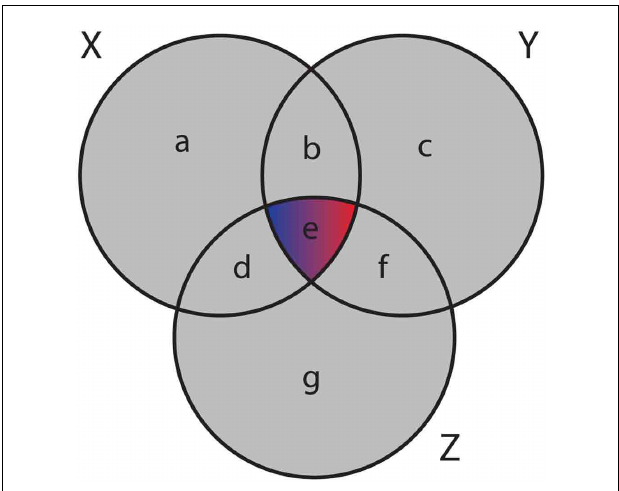
FIGURE 4 | GeneralizedVenn diagram showing the synergy Syn( X , Y ; Z ) =− I ( X ; Y ; Z ). The synergy is shown in red and blue because it can assume positive as well as negative